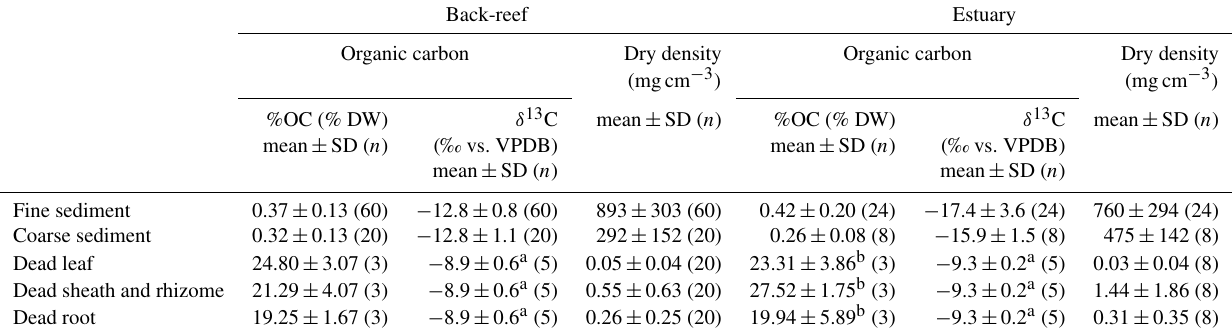
Table 2. Organic carbon content, δ 13 C, and dry density of each of sediment and dead plant component at the back-reef and estuarine sites. Back-reef Estuary Organic carbon Dry density Organic carbon